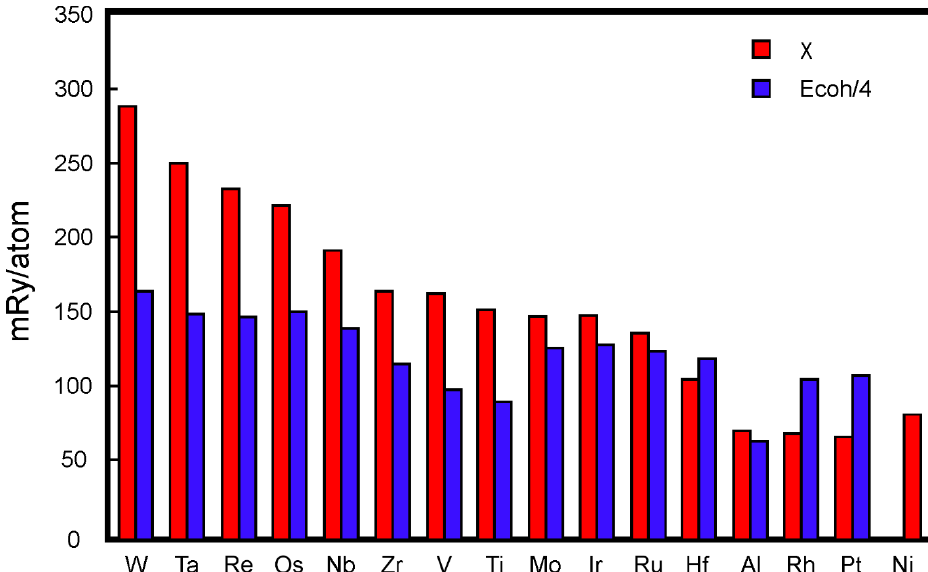
Figure 1. Calculated values of the χ parameter and the experimental cohesive energies (divided by 4) of alloying elements in Ni-based alloys [10,11]. Copyright 2008 Elsevier.